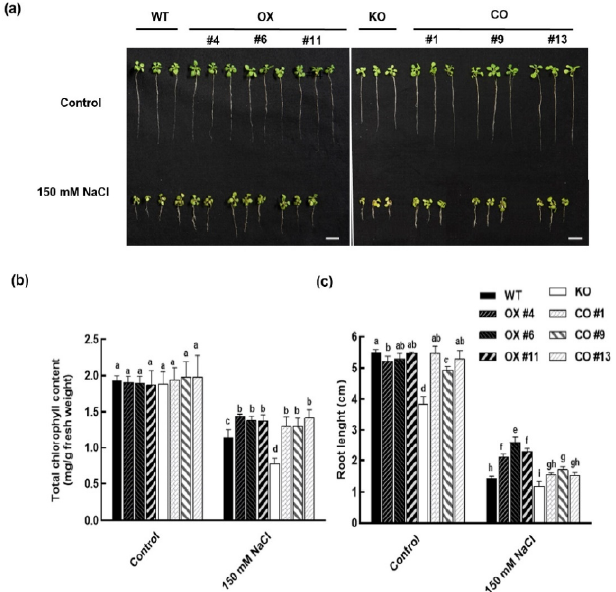
Figure 4. Effects of salt stress on seedling growth phenotype, chlorophyll, and root length in wild type (WT), BvbHLH93 -overexpression in wild type Arabidopsis (OX), atbhlh93 knock-out mutant (KO), and transgenic BvbHLH93 in the KO mutant (CO). ( a ) Eight-day-old seedlings were transferred to MS medium containing 150 mM NaCl for seven days. ( b ) Chlorophyll level and ( c ) root length in control and 150 mM NaCl treated seedlings. Different letters indicate significant difference at p < 0.05. Three biological replicates were